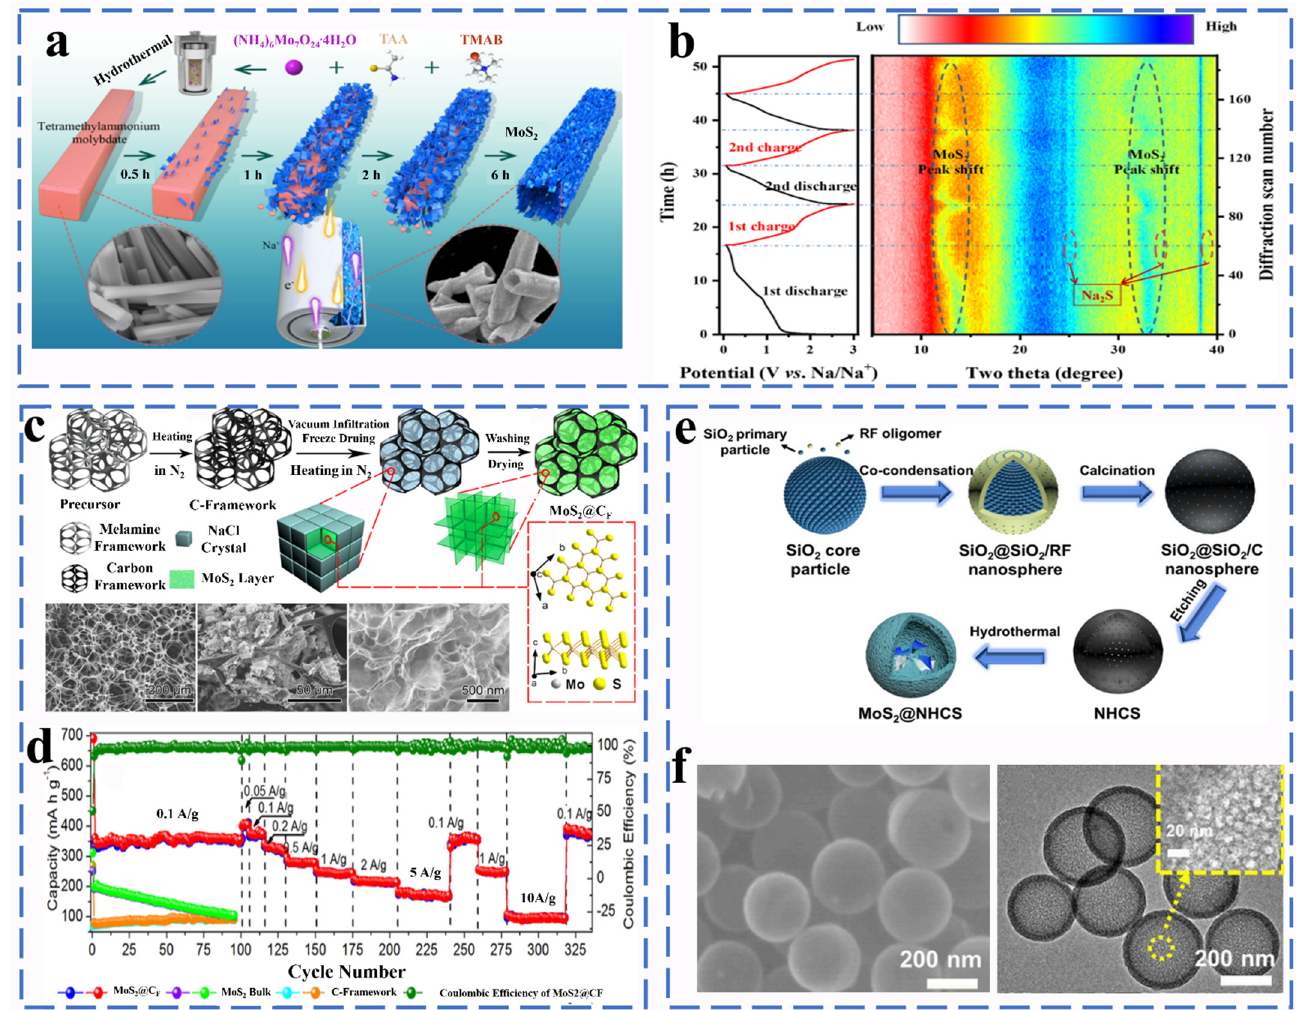
Figure 10. ( a ) Schematic illustration of the tubular MoS 2 hierarchical structures. ( b ) In situ XRD patterns for MS-T upon sodiation and desodiation. Reprinted with permission from [66]. Copyright